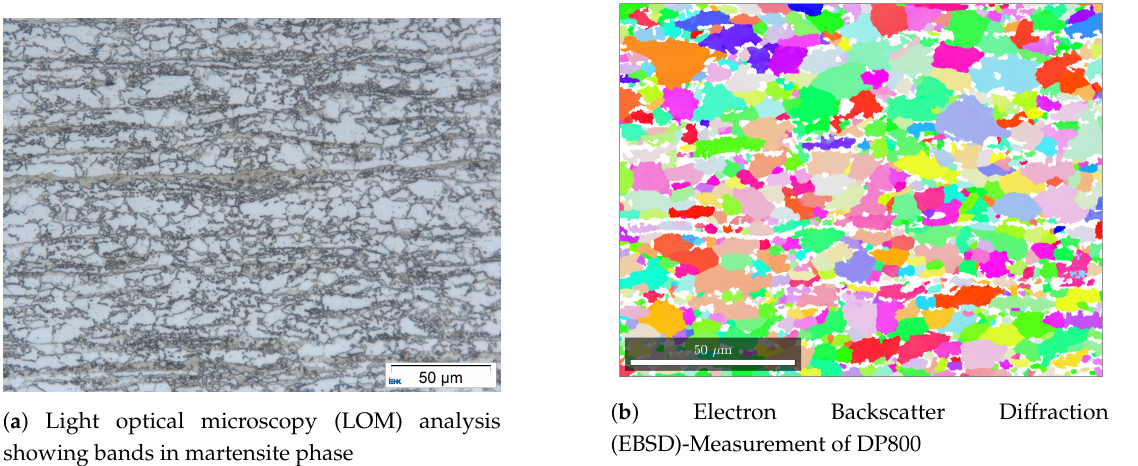
Figure 1. Microstructure analysis of